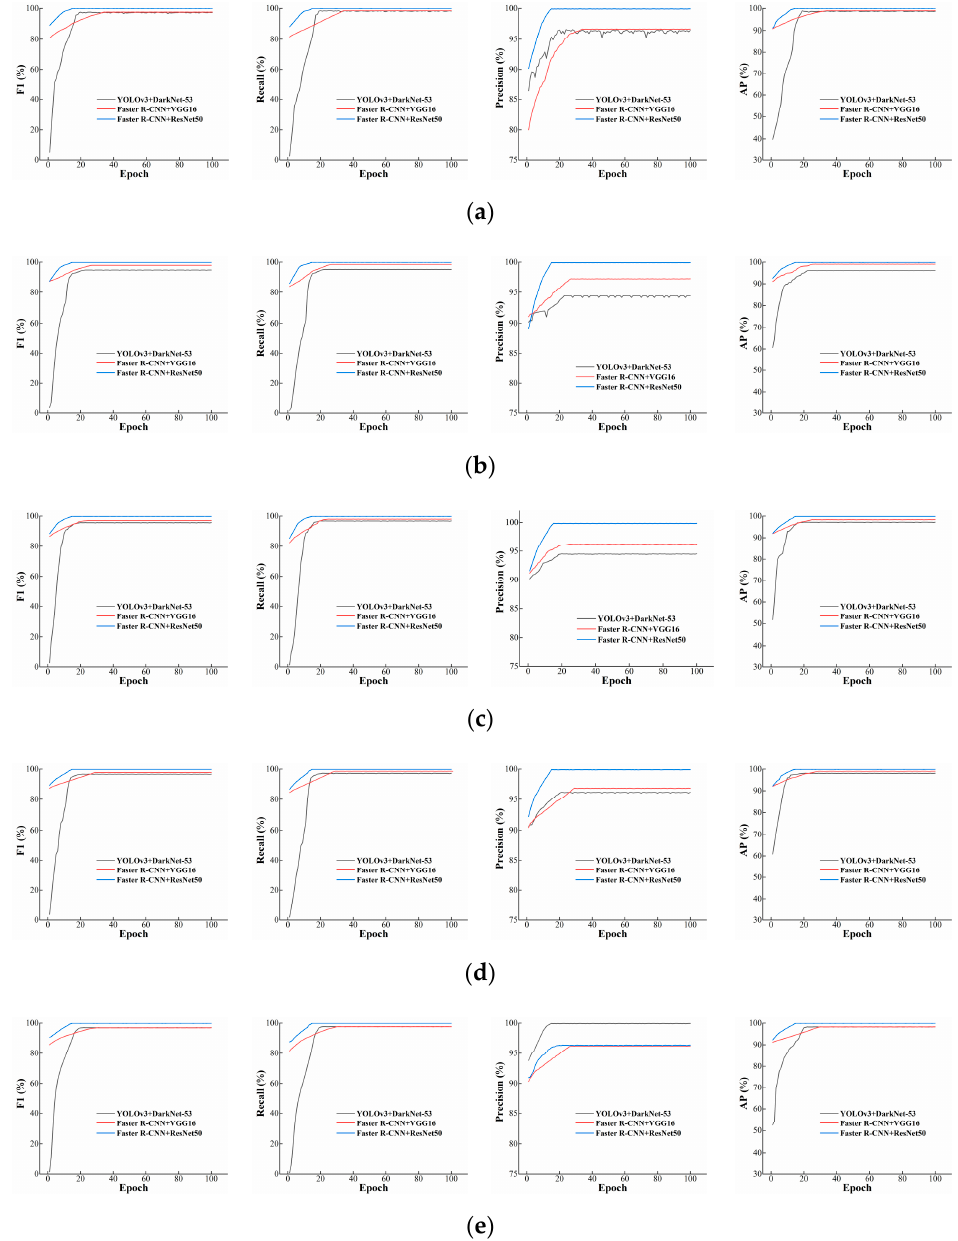
Figure 11. Identification of the training change curve for each index of the various types of cone yarns: ( a ) the training curve for each index of black twill bobbin yarn; ( b ) the training curve for each index of black fork bobbin yarn; ( c ) the training curve for each index of pure black bobbin yarn; ( d ) the training curve for each index of rose red bobbin yarn; ( e ) the training curve for each index of green twill bobbin